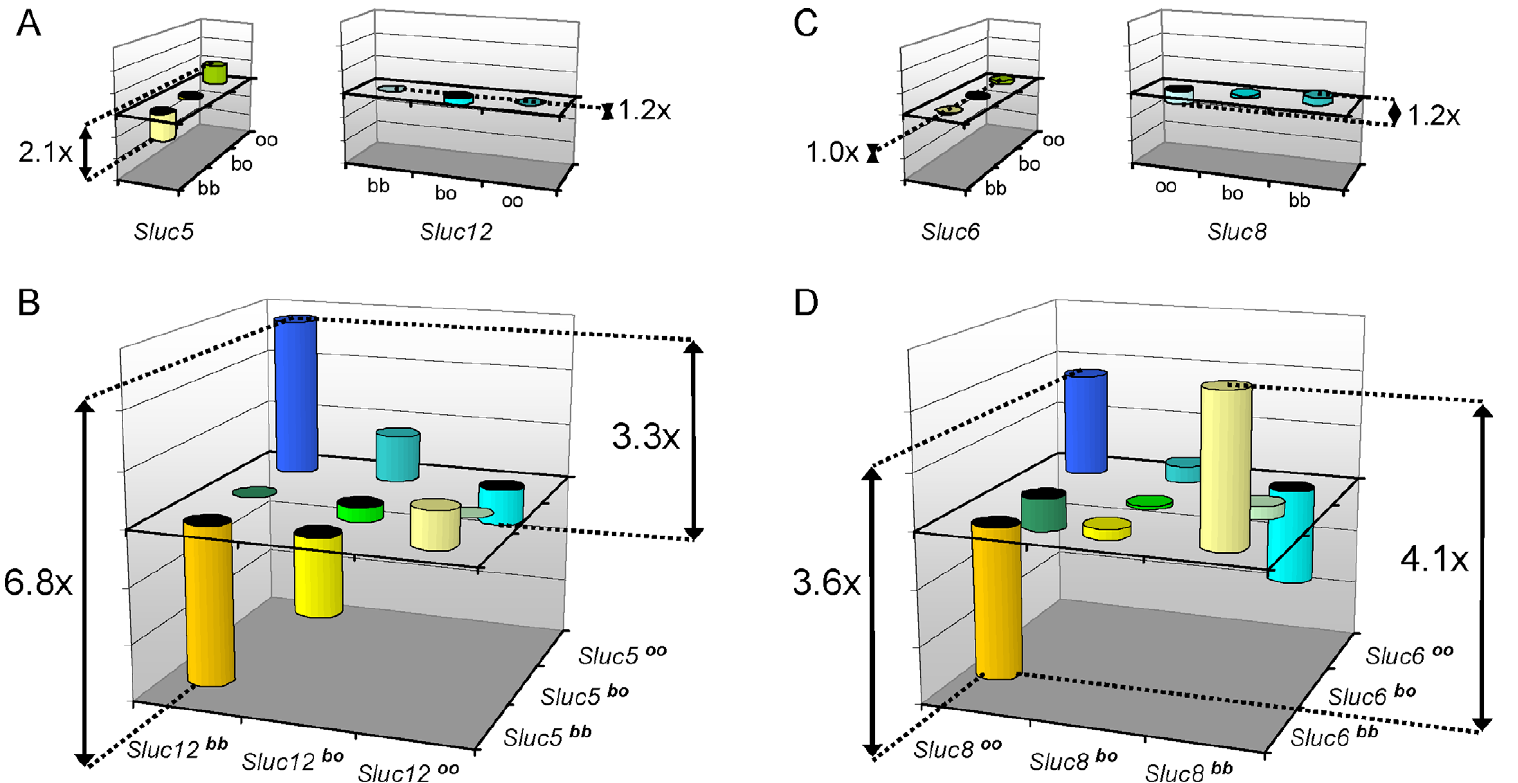
Fig. 1. Main-effects of TSGs are masked by their involvement in epistatic interactions. Graphic representation of estimated main-effects (A and C) and interaction effects (B and D) of lung cancer susceptibility loci Sluc5 and Sluc12 (A and B), and Sluc6 and Sluc8 (C and D), based on their original normalized mapping data [28]. The cylinders indicate magnitude and direction of deviation from the mean (horizontal planes). Genotypes of F2-hybrid mice are indicated by: ‘bb’, homozygosity for the b-allele; ‘bo’, heterozygosity; and ‘oo’, homozygosity for o-allele. A: The observed main-effect of genetic variation in the Sluc5 locus on lung tumor size (2.1-fold difference) is underestimated when genetic interactions are not taken into account. B: The main-effect of Sluc5 is large within the subset of mice that carry the Sluc 12 bb -genotype (6.8-fold difference), and relatively small in mice that carry the Sluc 12 oo -genotype. The Sluc12 locus also affects lung tumor size (up to 3.3-fold difference), in a Sluc5 -dependent manner. C: The main-effects of Sluc6 and Sluc8 on lung tumor number are completely annihilated by their involvement in a counteracting interaction. D: Both Sluc6 and Sluc8 cause significant differences in tumor number (up to 3.6-fold and 4.1-fold, respectively); however, the direction of their effects depends on the genotype of their interacting